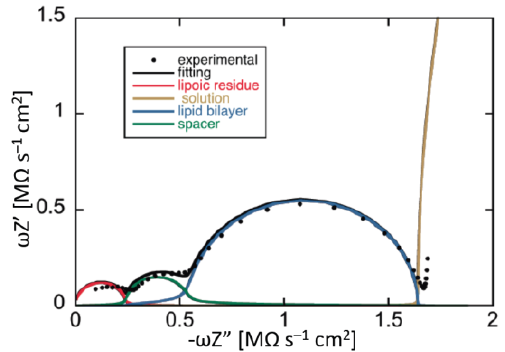
Figure 13. Plot of ωZ ′ (solid circles) against − ωZ ″ for a mercury-supported DPTL/DPhPC bilayer Figure 13. Plot of ω Z (cid:48) (solid circles) against − ω Z (cid:48)(cid:48) for a mercury-supported DPTL/DPhPC bilayer incorporating valinomicin from its 0.15 μM solution in aqueous 0.1 M KCl at −0.41 V vs. saturated incorporating valinomicin from its 0.15 µ M solution in aqueous 0.1 M KCl at − 0.41 V vs. saturated calomel electrode (SCE). The solid black curve is the best fit of the impedance spectrum by the calomel electrode (SCE). The solid black curve is the best fit of the impedance spectrum by the equivalent equivalent circuit shown in the inset of Figure 12, with R l = 2.8 M  ·cm 2 , C l = 4.2 μF·cm −2 , R s = 48 k  ·cm 2 , circuit shown in the inset of Figure 12, with R l = 2.8 M Ω · cm 2 , C l = 4.2 µ F · cm − 2 , R s = 48 k Ω · cm 2 , C s = 3.3 μF·cm −2 , R m = 3.4 k  ·cm 2 , C m = 0.9 μF·cm −2 , R  = 3.7  ·cm 2 , C  = 43 nF·cm −2 . The colored curves C s = 3.3 µ F · cm − 2 , R m = 3.4 k Ω · cm 2 , C m = 0.9 µ F · cm − 2 , R Ω = 3.7 Ω · cm 2 , C Ω = 43 nF · cm − 2 . The colored are contributions to ωZ ′ from the single slabs. (Adapted with permission from [61]. Copyright 2005 curves are contributions to ω Z (cid:48) from the single slabs. (Adapted with permission from [61]. Copyright American Chemical Society). 2005 American Chemical